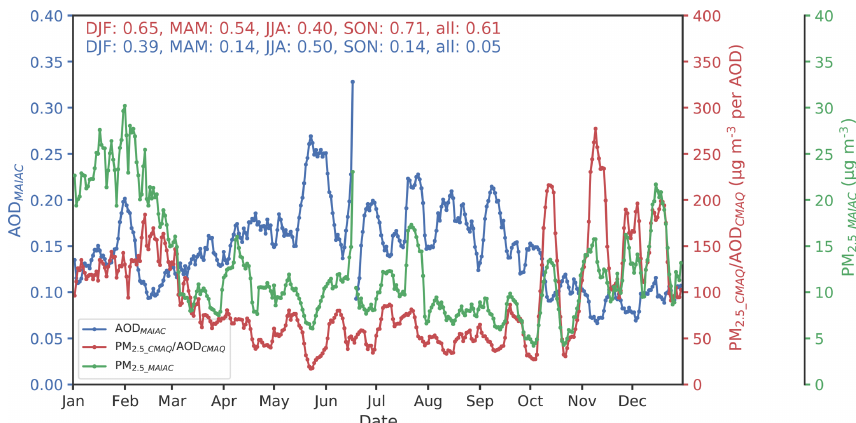
Figure 2. Regional 10-day running average of (a) MAIAC AOD (AOD MAIAC , blue), (b) CMAQ modeled PM 2 . 5 / AOD relationship (PM 2 . 5_CMAQ / AOD CMAQ , red), and (c) satellite-derived PM 2 . 5 (PM 2 . 5_MAIAC , green). The numbers on the upper left corner show the Pearson correlation coefficients ( R ) of PM 2 . 5_MAIAC with PM 2 . 5_CMAQ / AOD CMAQ (red) and AOD MAIAC